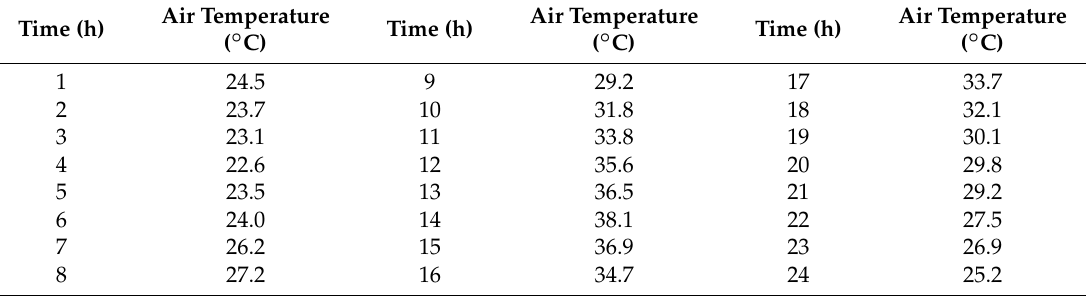
Table 8. Air temperature per hour over a 24-h span in